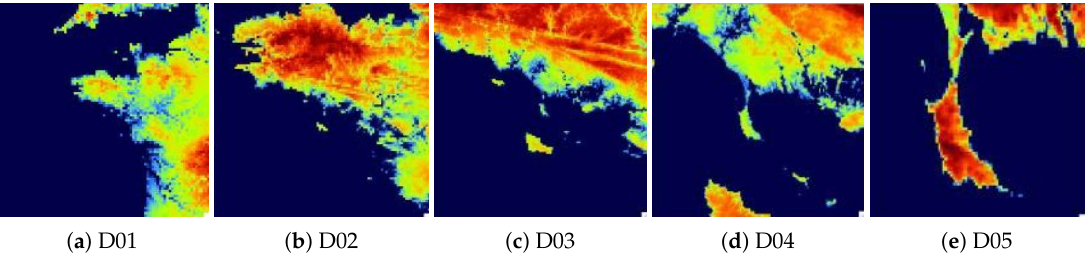
Figure 9. Spatial domains of the modelling used to predict the wind above the sailing area, from the wider ( a ) to the closer ( e ) (Source: EXWEXs [38]).